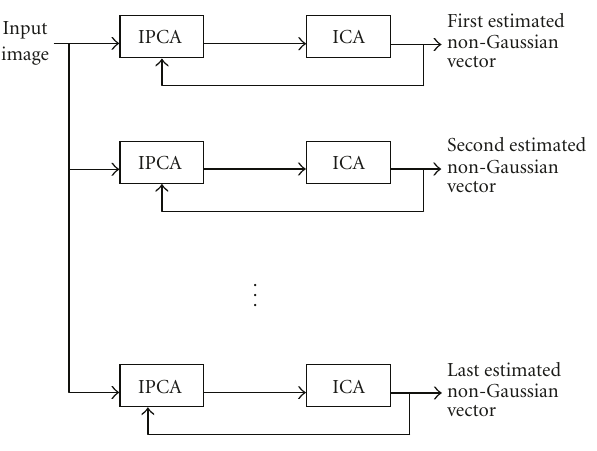
Figure 3: IPCA-ICA algorithm block